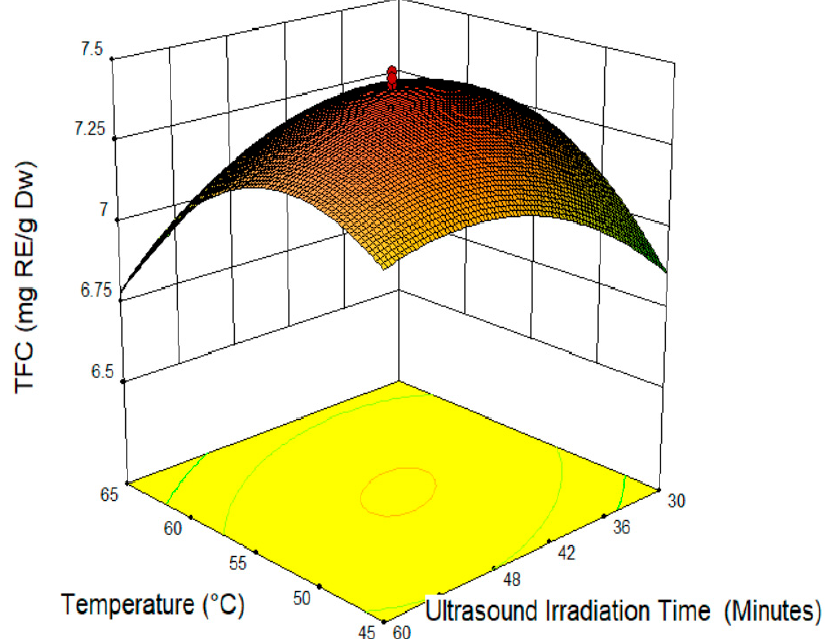
Figure 3. Response surface plot of temperature (X 2 ) and ultrasound irradiation time (X 3 ).